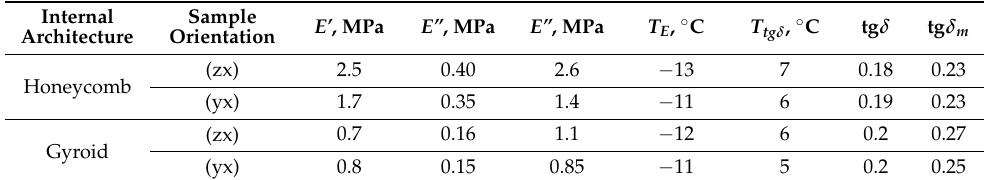
Table 2. Viscoelastic properties of lattice flexible TPU.